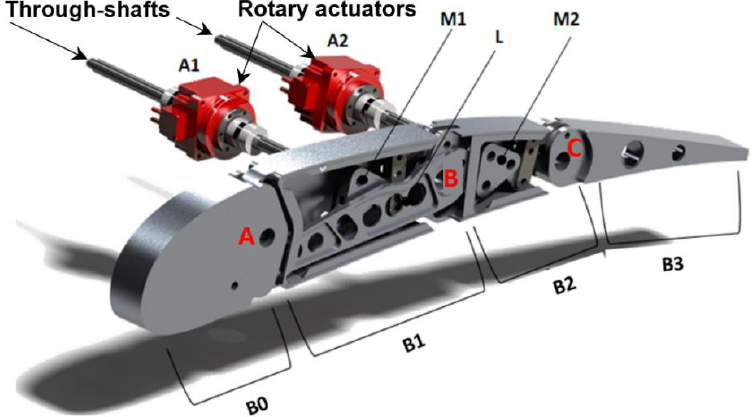
Figure 1. General layout of CleanSky2 Camber Morphing Flap . Each flap rib consists of four consecutive blocks (B0, B1, B2, and B3) hinged along the camber line at the positions marked by points A, B, and C in Figure 2. Block B0 and B2 are